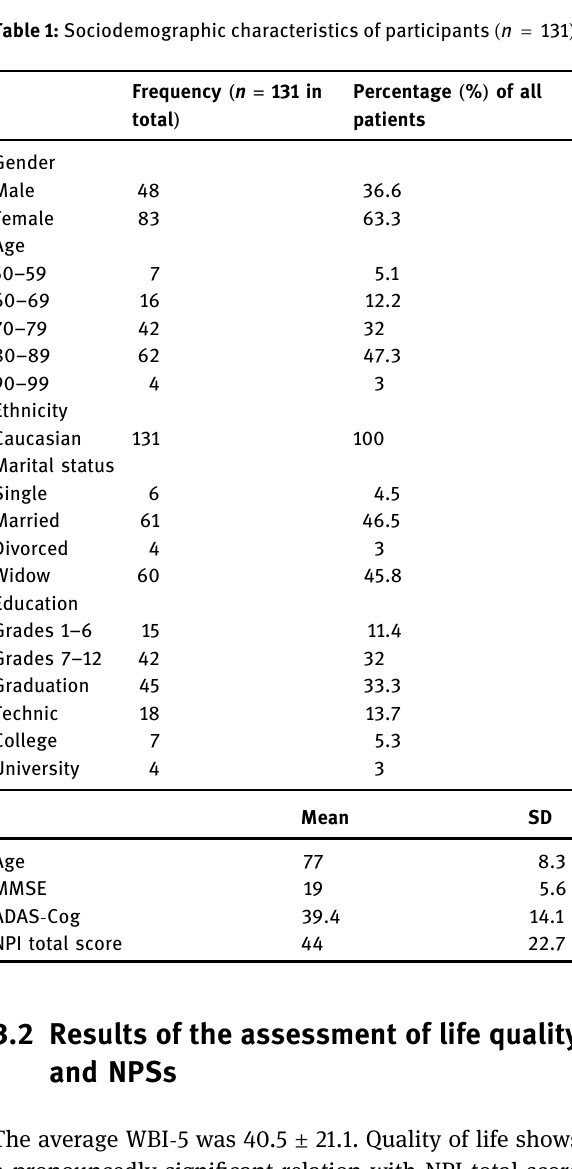
Table 1: Sociodemographic characteristics of participants ( n = 131 )